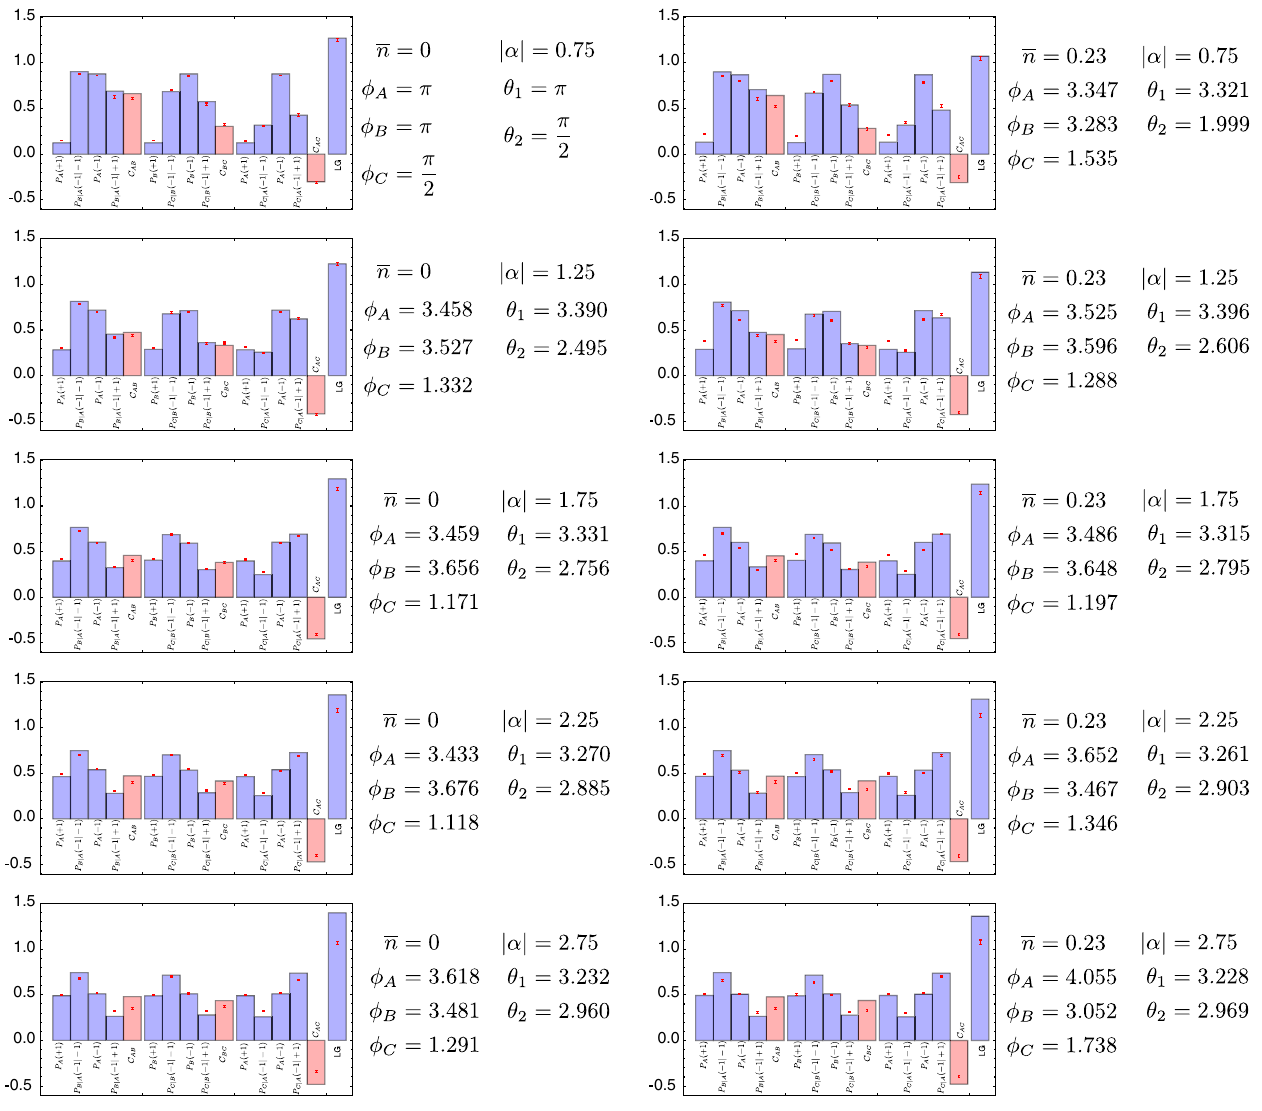
FIG. 10. A sample of individual detection data and measurement settings for the Leggett-Garg violations presented in Fig. 4(b) of the main text. The data are from the set ¯ n ≈ 0 and ¯ n ≈ 0 . 23 . Data are shown as red points, while the expectations for an ideal experiment are shown as bars. Blue bars are the detection data, and the three red bars show the correlations calculated from these detections. We see qualitatively good agreement for smaller α , which decreases for higher displacements, mainly due to dephasing noise in the experimental system. The settings θ 1 and θ 2 correspond to θ θ − θ θ θ − θ 1 ¼ B A , 2 ¼ C B